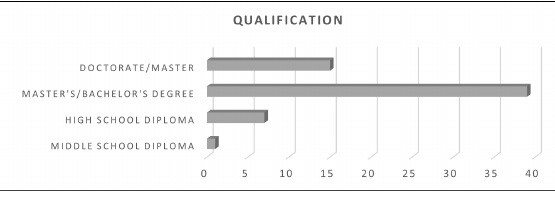
Figure 2: Frequency distribution of qualification.